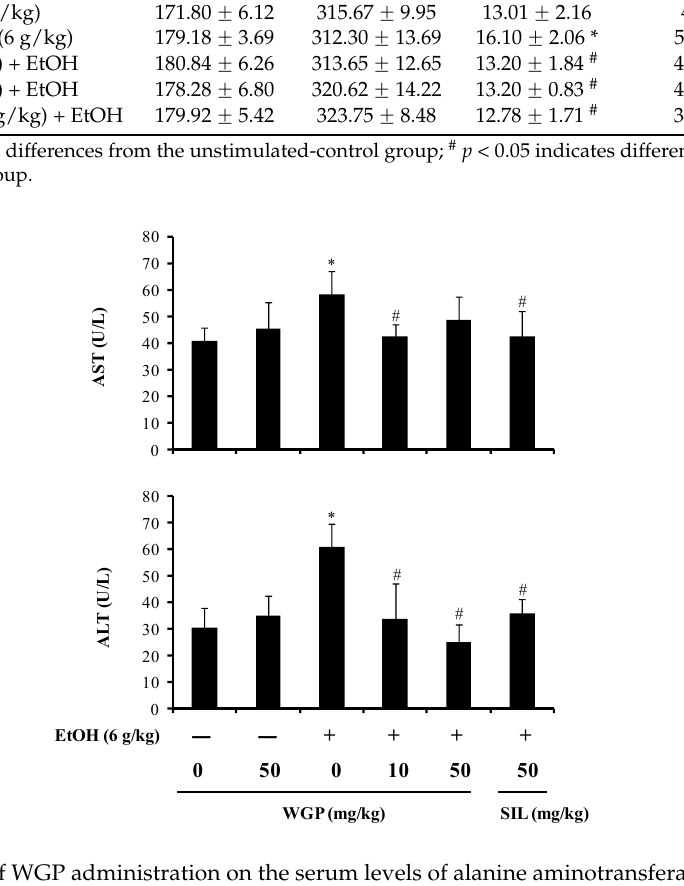
Figure 5. Effects of WGP administration on the serum levels of alanine aminotransferase (ALT) and aspartate aminotransferase (AST) in ethanol-treated Sprague-Dawley (SD)-rats. Each value represents the mean ± SD for five rats. * p < 0.05 indicates differences from the unstimulated-control group; # p < 0.05 indicates differences from the ethanol-treated group.